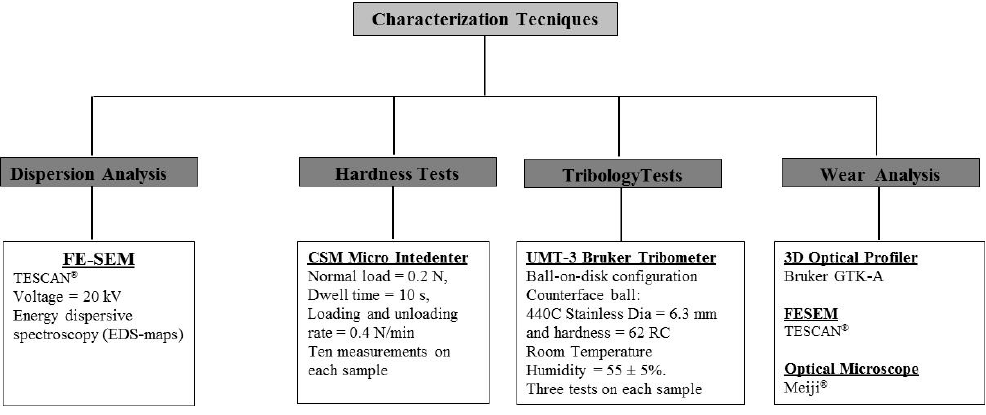
Figure 3. Summary of all the characterization techniques used in the present study.